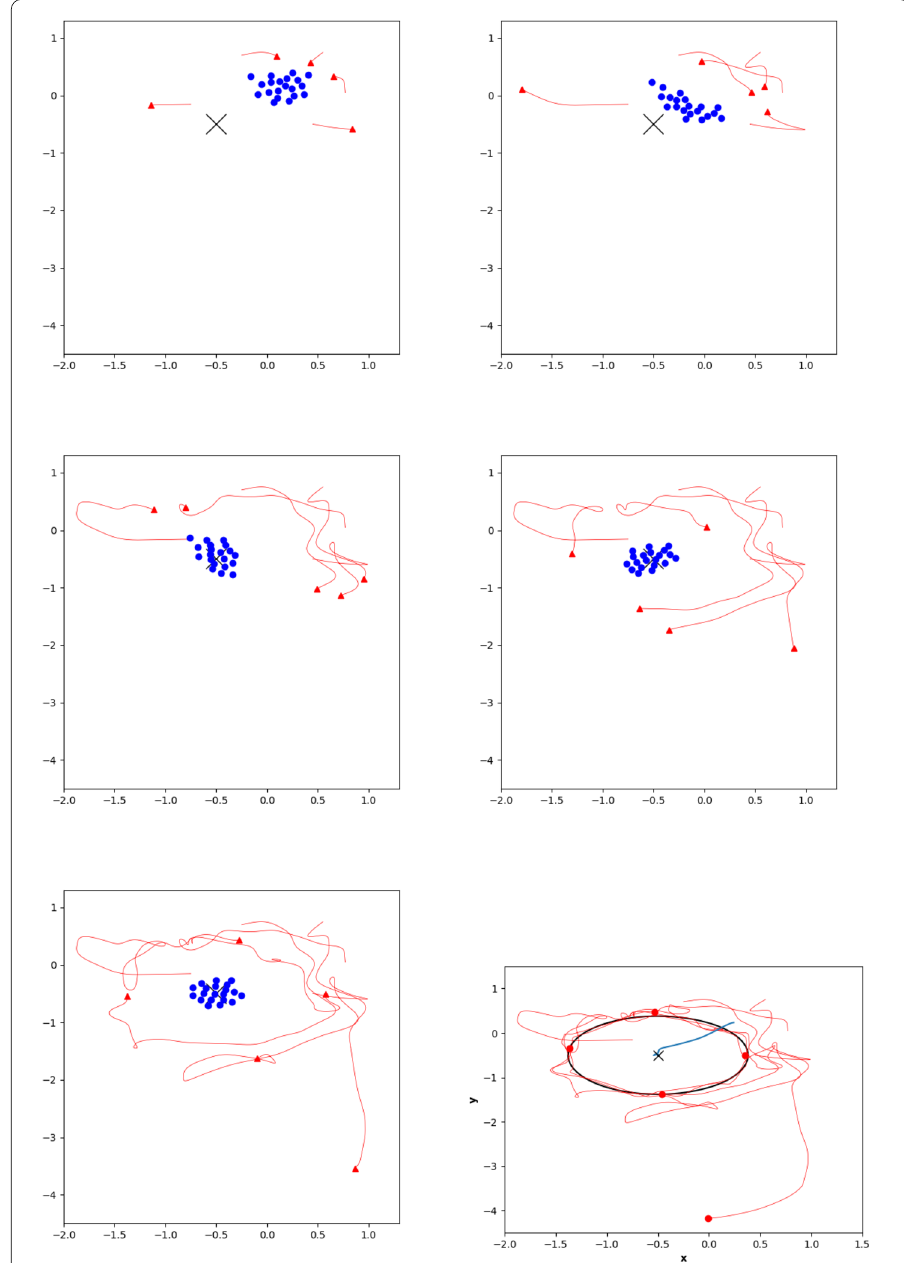
Figure 4 Snapshots of the optimization procedure at t = 10,25,50,75,125,250 (top-left to bottom-right). We see that the five dogs are able to steer the centre of mass of the crowd to the destination and that the crowd stays together. The latter is a new information which is not accessible by investigating only the centre of mass. Moreover, we see a stabilization as the dogs begin to circle around the crowd ( t = 75,125,250) after the centre of mass reached the desired destination. The black circle is underlining the discussion of the stabilization of the crowd